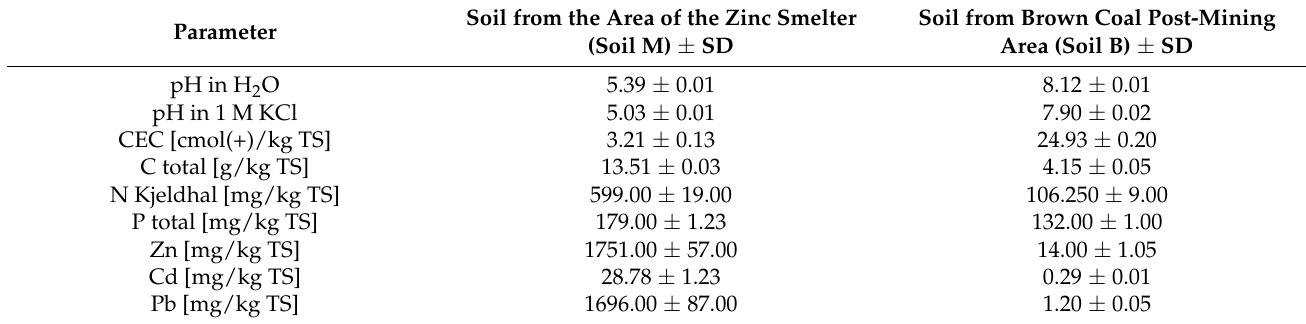
Table 4. Selected chemical and physical parameters of the soils.